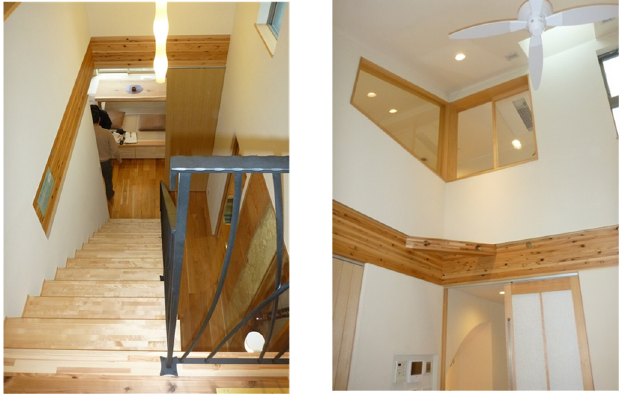
Figure 17. Fittings isolating the atrium.